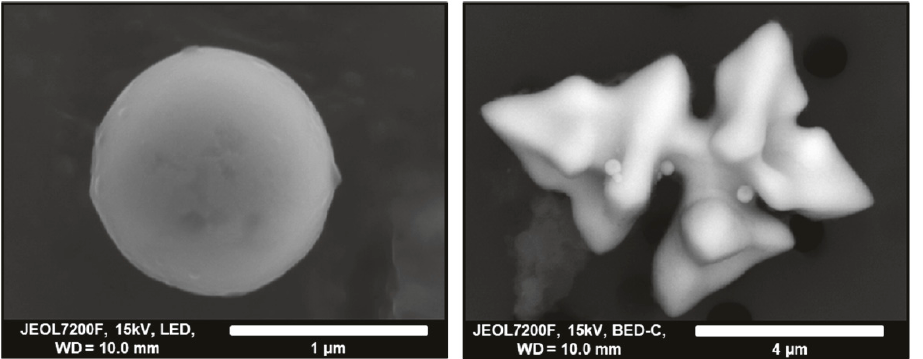
Figure 12. Electrolytically extracted inclusions using the choline chloride solution as mentioned in Mayerhofer et al. [68]. Adapted from Ph.D thesis of Alexander Mayerhofer [68].